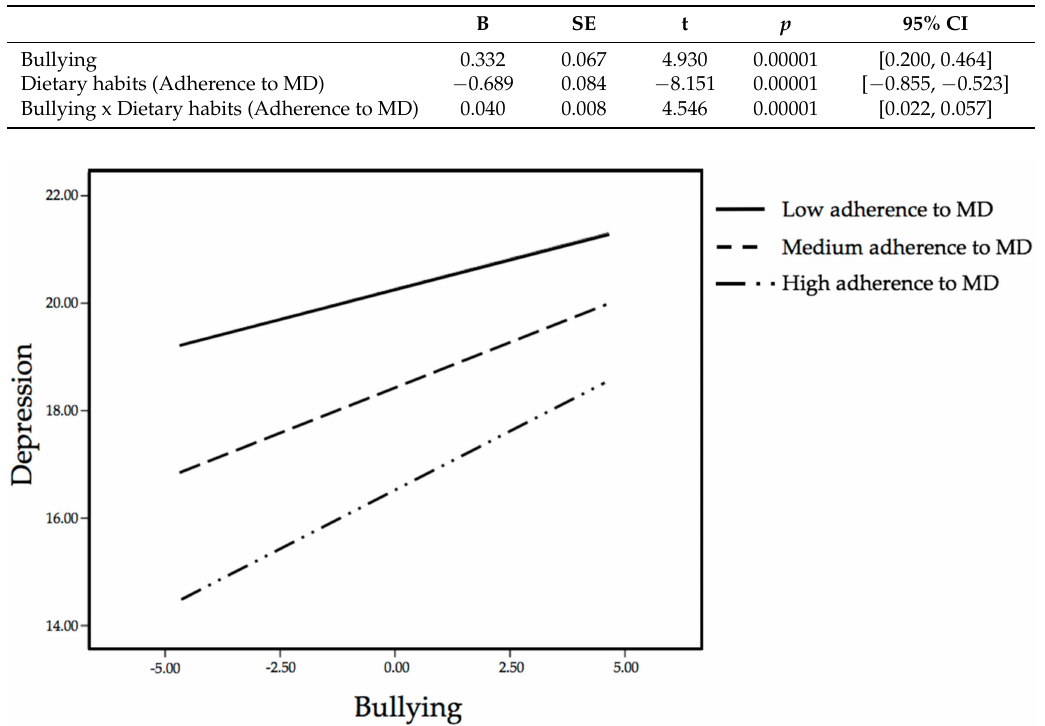
Table 4. Moderation of the relationship between bullying and depression by dietary habits (Adherence to MD).